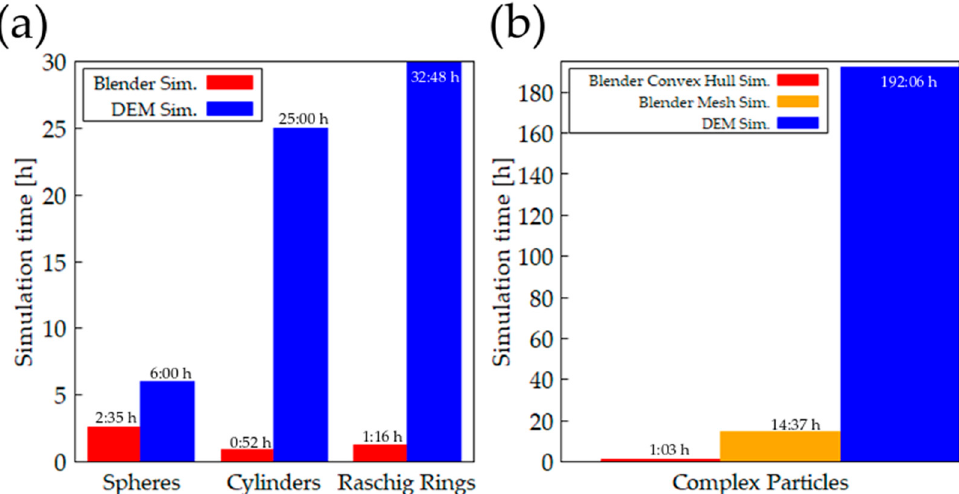
Figure 14. Simulation Time of Blender and DEM for different particle shapes. ( a ) Spheres, Cylinders and Raschig Rings; ( b ) Complex Particles.